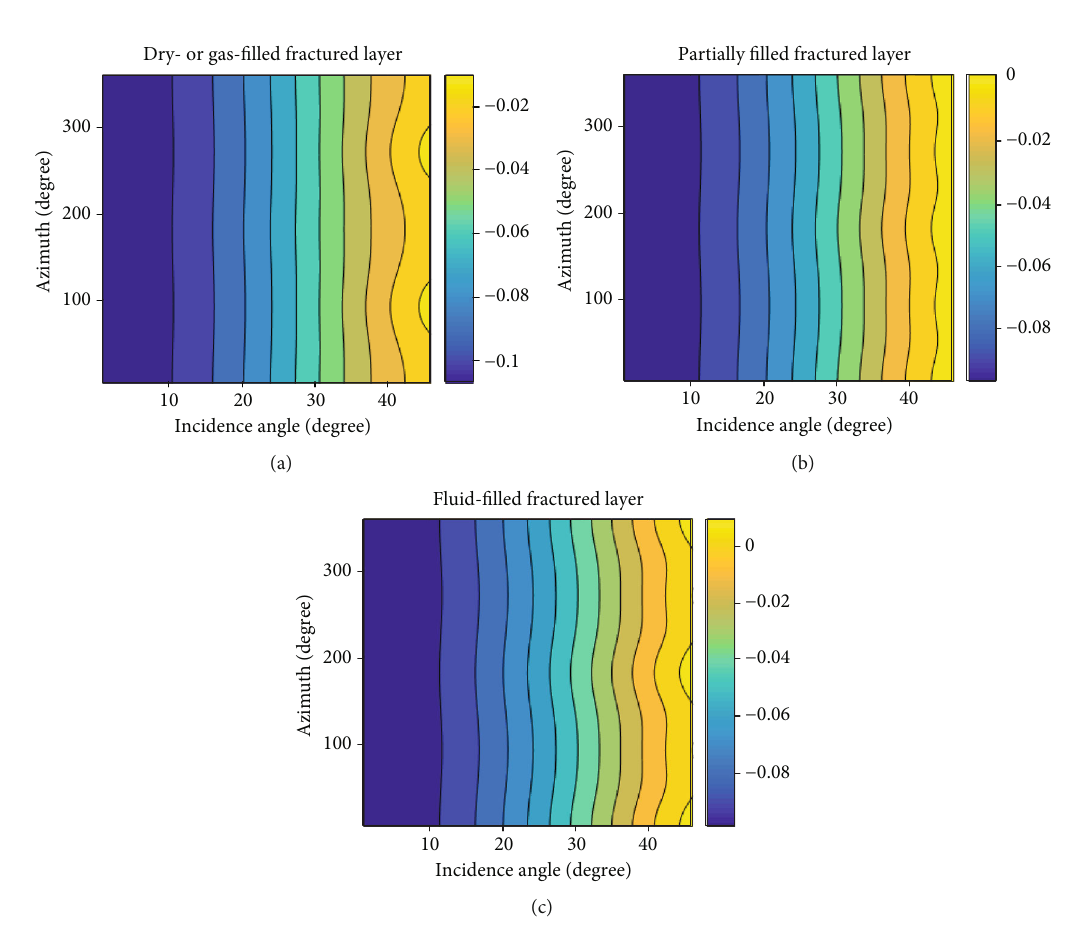
Figure 2: The sensitivity of PP-wave re fl ection coe ffi cient to the fl uid content of titled fractured reservoirs with fi xed dip angle, where (a) is dry or gas-saturated, (b) is partially saturated, and (c) is fully saturated.